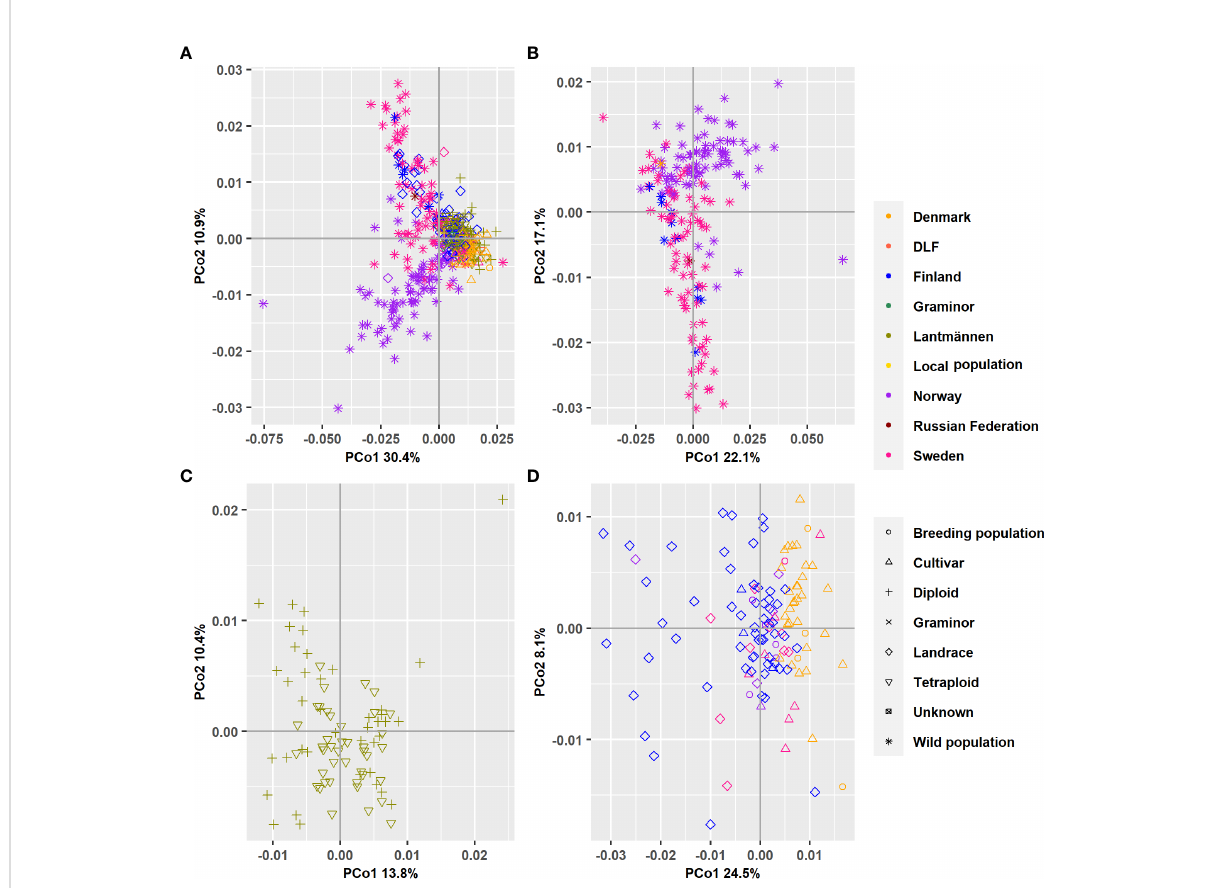
FIGURE 4 A bi-plot of the principal coordinate analysis (PCoA) showing the variation explained by the fi rst two principal components. (A) All 382 populations ’ analyzed together and separate analysis when the accessions have been grouped according to wild populations (B) Lantmännen populations (C) or Landraces and cultivars held at NordGen (D)